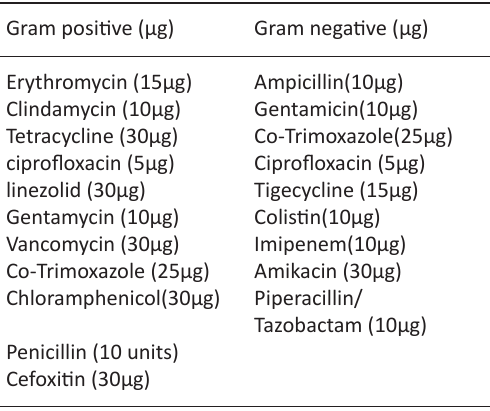
Table 1. Showing the antibiotics used in the study